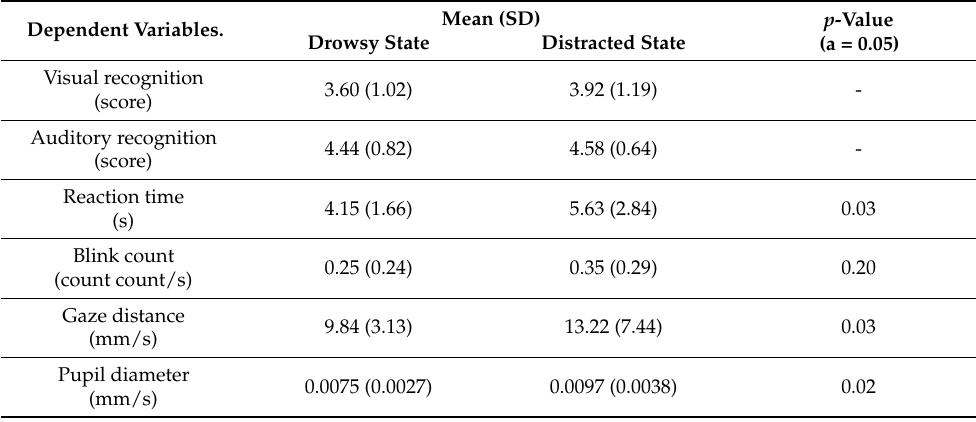
Table 4. Means and SD of the dependent variables. Dependent